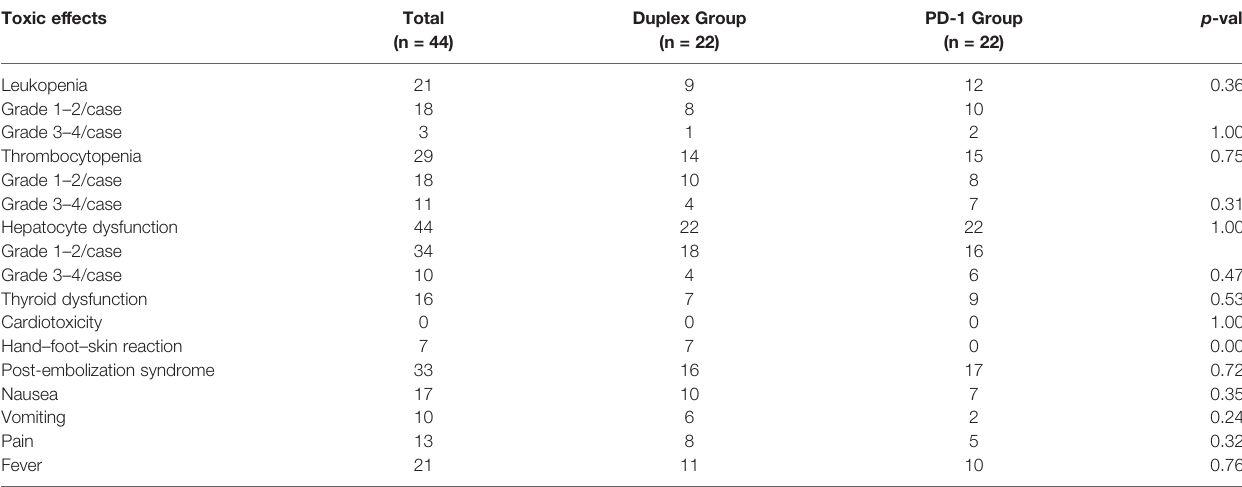
TABLE 3 | Safety assessment of the two study groups. Toxic